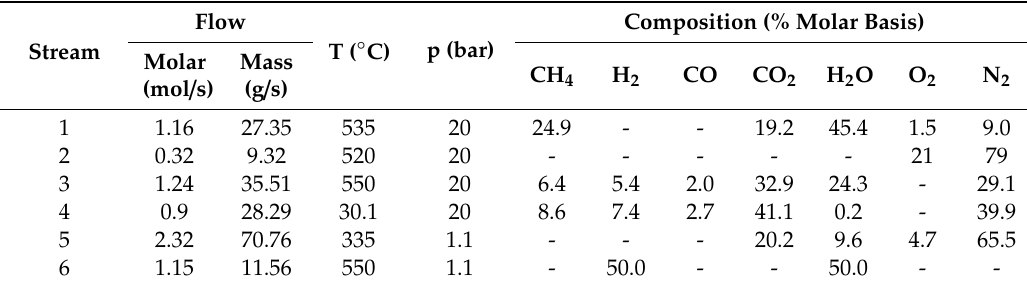
Table 7. New reactor dimensioning compared to BIONICO.